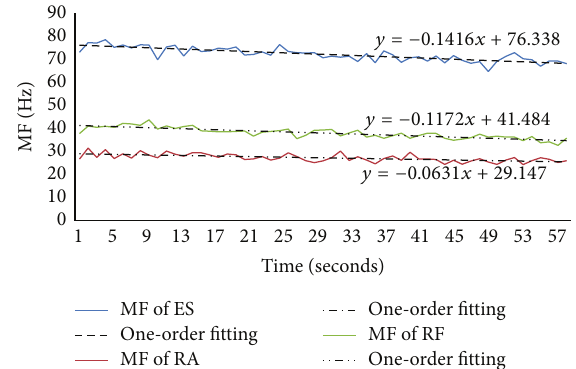
Figure 8: The MF and its one-order fitting for ES, RA, and RF muscles in the exercise of supine